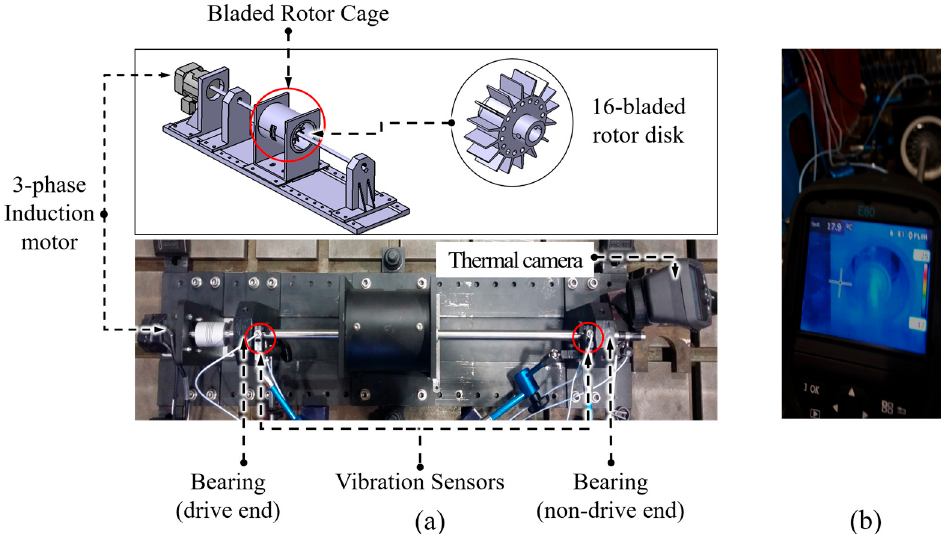
Figure 2. The test rig used for data collection: ( a ) the model and actual view of the rotor system; ( b ) the screen of the thermal camera used for validating the severity of the mechanical fault.